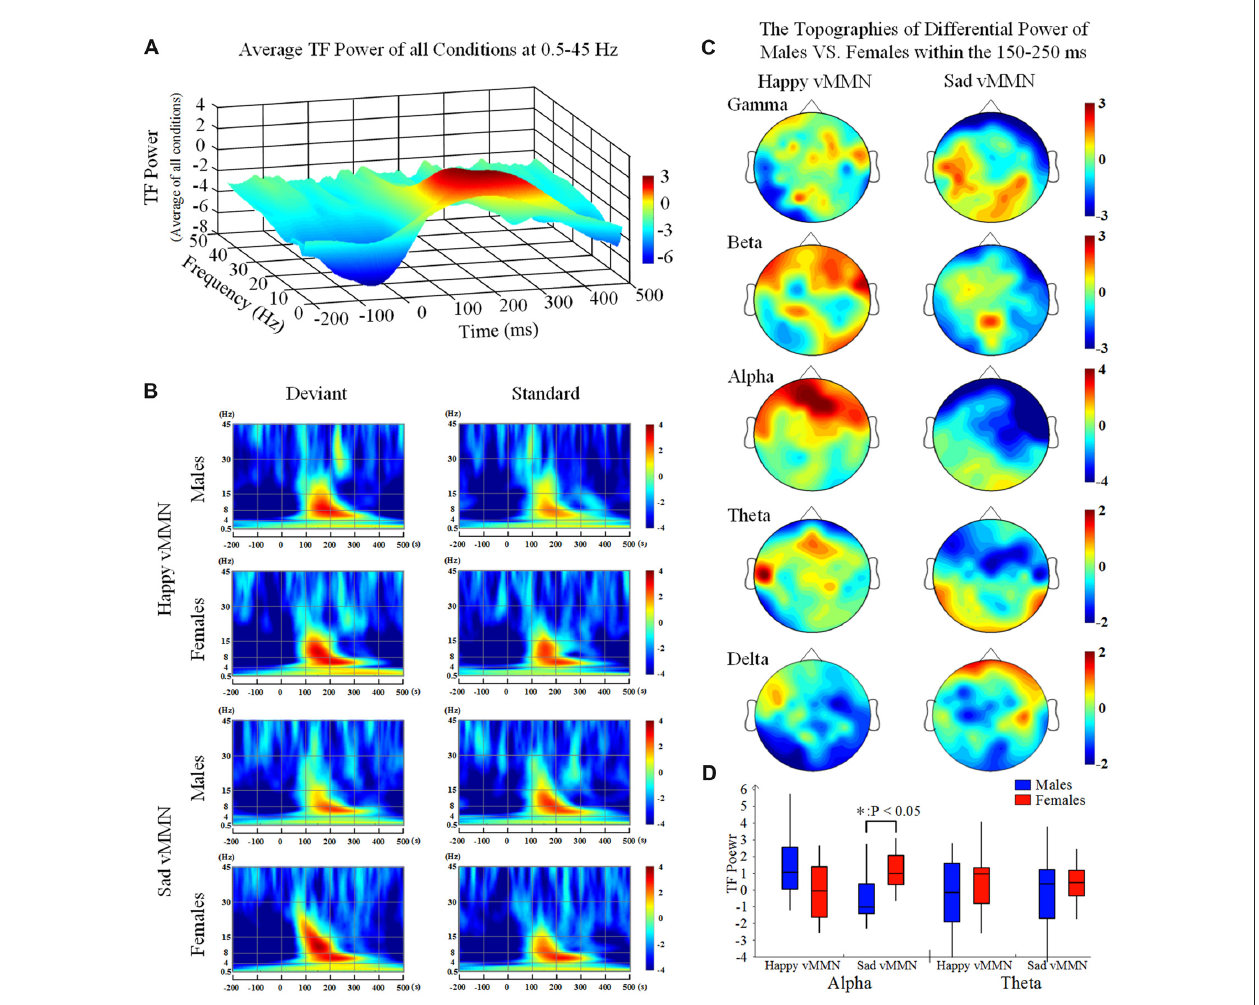
FIGURE 2 | (A) The average time-frequency (TF) power at 0.5–40 Hz from − 200 ms to 1,000 ms after the onset is illustrated at the all electrodes. (B) The TF power shows the phase-locked spectral power at 0.5–45 Hz from − 300 ms to 500 ms in response to the happy and sad facial stimuli at all electrodes. (C) The topographies illustrate the differential power levels related to males vs. females in a 100-ms time window (from 150 ms to 250 ms) in the all bands. (D) A box-plot of the TF power for males and females regarding the happy and sad visual mismatch negativity (vMMN) in terms of the alpha and theta band activity levels during the 150–250-ms time window. ∗ p <